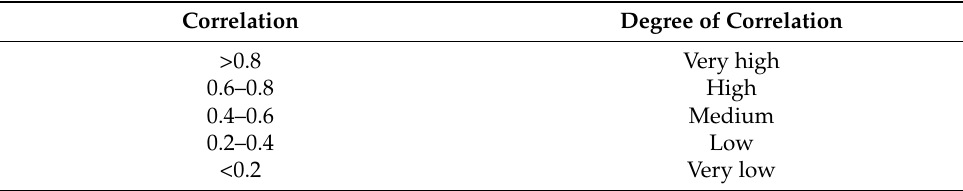
Table 4. Pearson